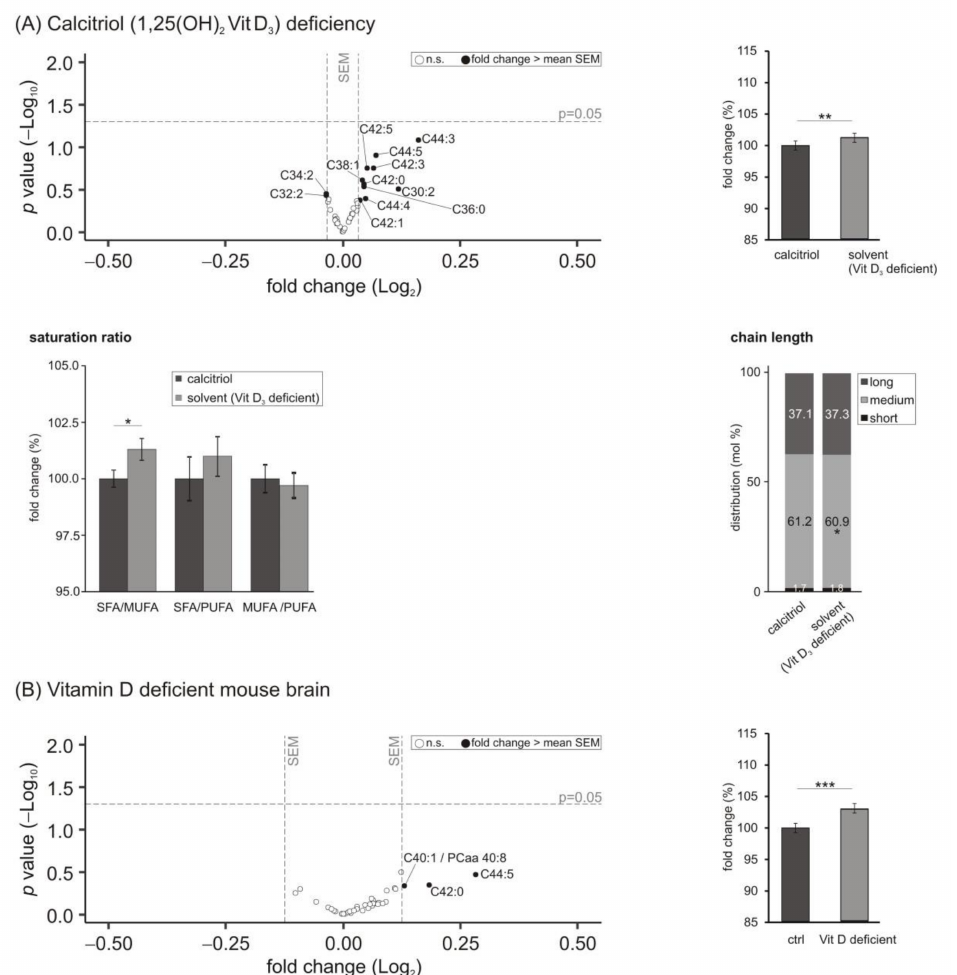
Figure 2. Effect of vitamin D 3 deficiency on phosphatidylcholine plasmalogens (PCae) species. ( A ) The levels of PCae in SH-SY5Y wt cells incubated with the solvent control (ethanol) were compared to cells treated with 1,25-dihydroxy vitamin D 3 . In the volcano plot, the fold change ( x -axis) of each of the 39 analyzed PCae species (dots) was plotted against the corresponding p -value ( y -axis). The volcano plots are structured as described in detail in the legend of Figure 1. The bar chart on the right shows the relative fold change of all measured PCae species comparing calcitriol-treated with solvent-control-treated SH-SY5Y cells. Below the volcano plot, ratios dealing with the saturation state of the fatty acids within the PCae species and the distribution of chain length in mol% are shown. ( B ) Analyzed PCae species in brain samples of vitamin D deficient mice compared to control-fed mice in a volcano plot and relative fold changes of all measured PCae species in a bar chart. Error bars represent the standard error of the mean (SEM). Statistical significance was set as * p ≤ 0.05, ** p ≤ 0.01 and *** p ≤ 0.001; n.s. not